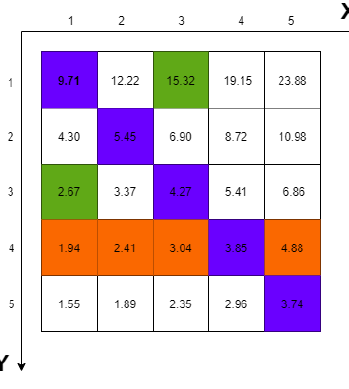
Figure 1. The similarity matrix between x and y . The elements marked green, orange and purple are sampled to illustrate the unsatisfied properties of the log-transformed Bayesian